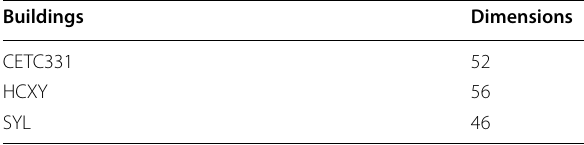
Table 3 Number of samples in different sheets Buildings